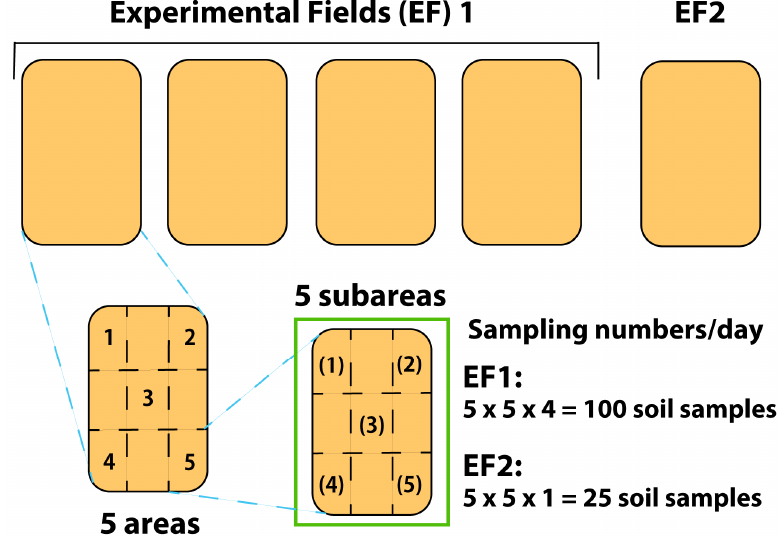
Figure 1. Information of experimental fields and soil sampling.